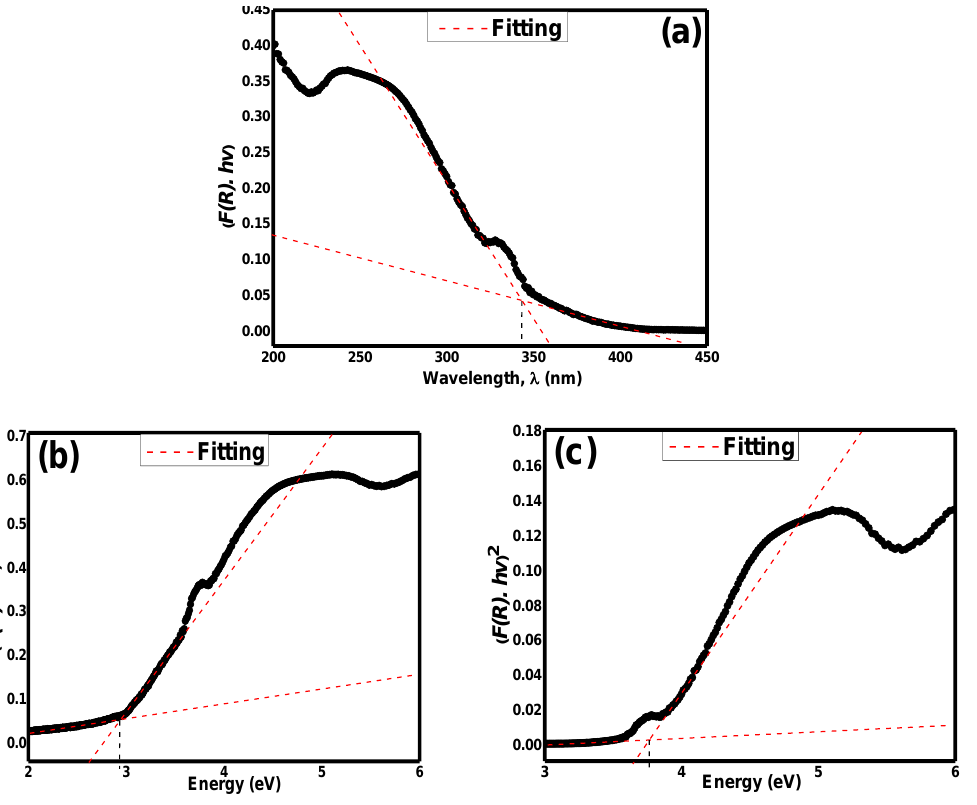
Figure 9. ( a ) The Kubelka–Munk, Tauc plotting of ( b ) allowed indirect transition and ( c ) allowed direct transition in Sr 2 CaTeO 6 (dotted lines are the fitting for optical band gap).